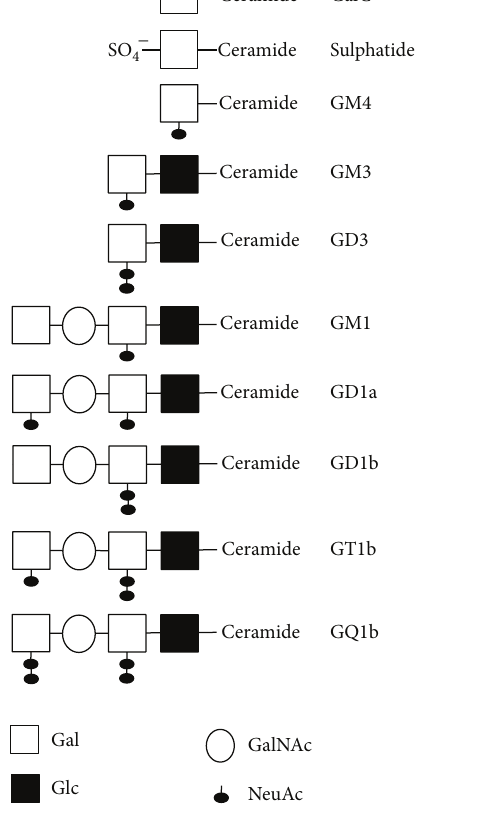
Figure 4: Schematic showing the relationship between the galac- tosylceramides (GalC and sulphatide) and some of the gangliosides present in the CNS [84, 176]. The nomenclature of the gangliosides indicates whether they are mono-, di-, tri-, or tetrasialoganglio- sides (GM, GD, GT, and GQ, resp.), their order of migration on thin-layer chromatograph (e.g., GM3 migrates further than GM1), and variations in basic structure (e.g., GD1a versus GD1b). GalC: galactocerebroside; Glc: glucose; Gal: galactose; GalNAc: N- acetylgalactosamine; NeuAc: N-acetylneuraminic acid (sialic